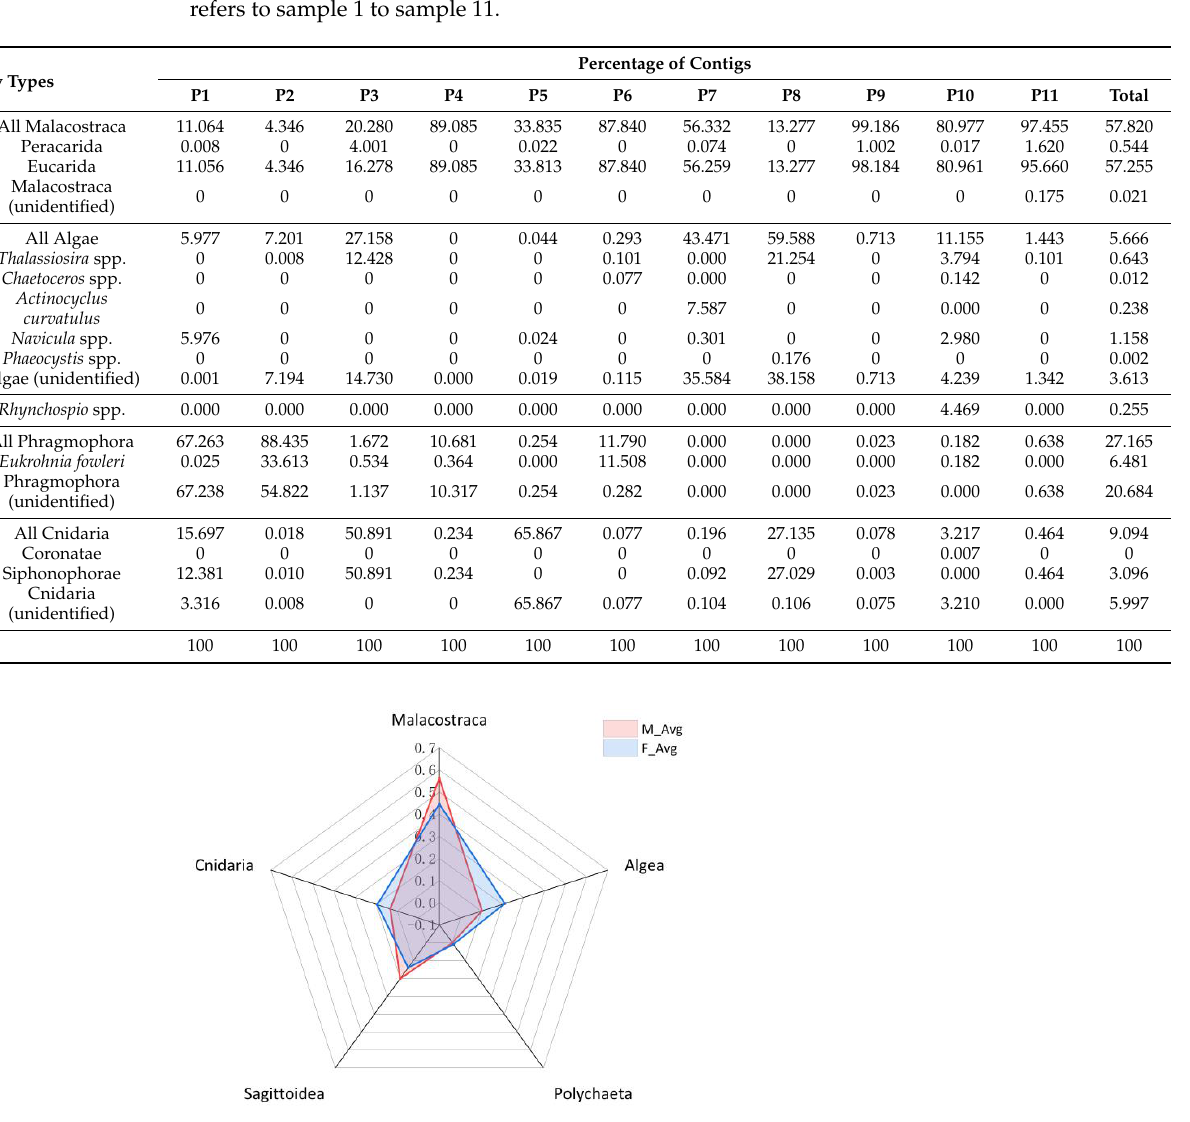
Table 5. List and proportions of prey items of M. caml as determined by NGS analysis. P1 to P11 refers to sample 1 to sample 11.